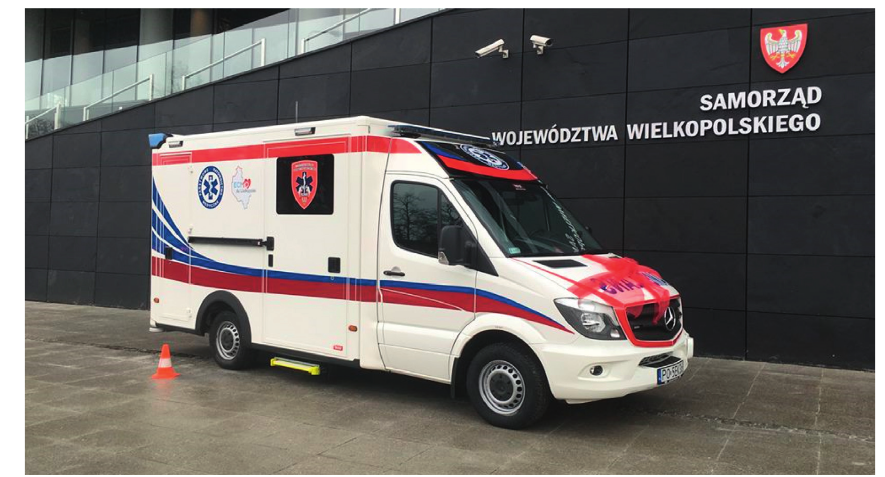
Figure 2: Ambulance used to transport critically ill patients in “ECMO for Greater Poland”